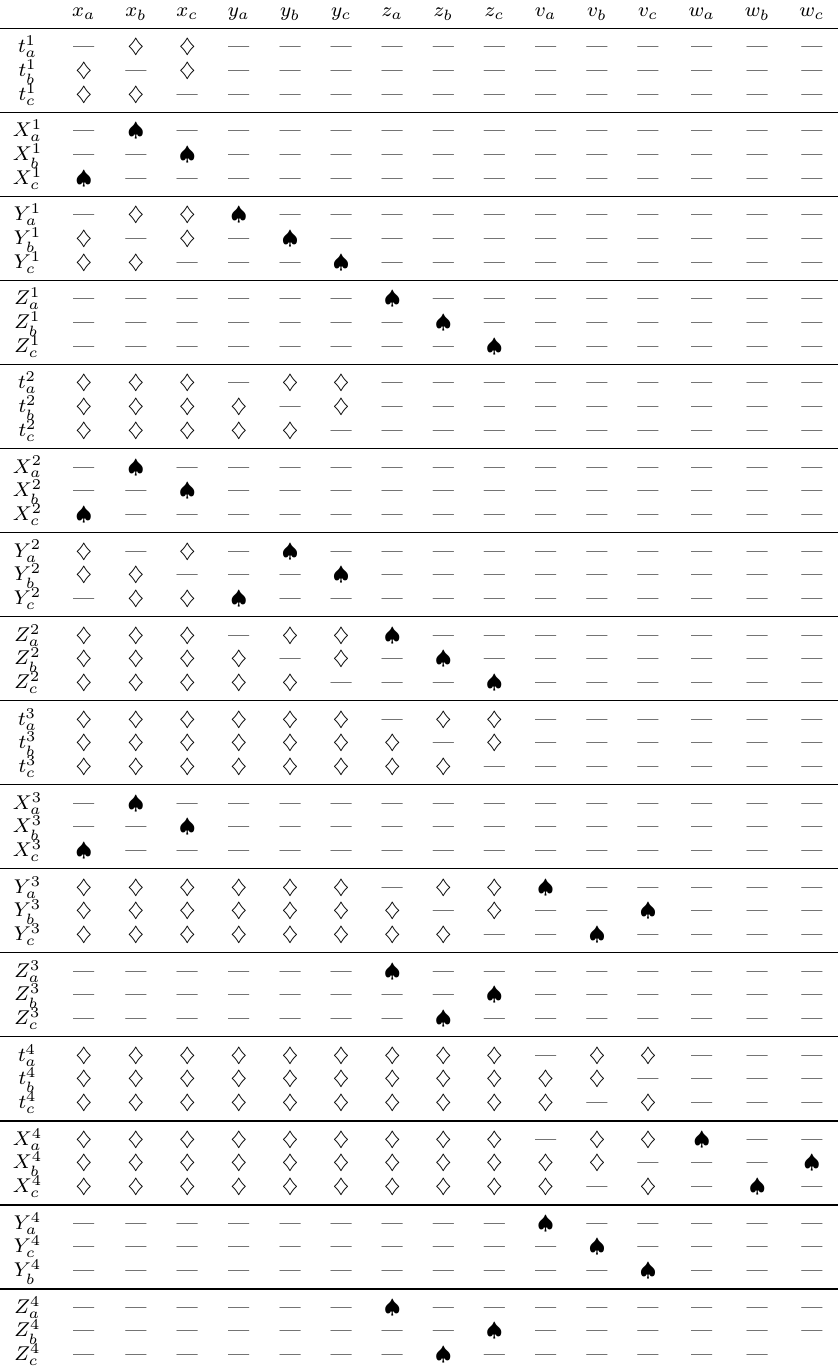
Table 3: Data propagation in the proposed S-box implementation. Row: intermediate values, column: inputs. The names of intermediate values and inputs follow Fig. 8. ♦ / ♠ is placed if the intermediate result depends on the input. ♠ is placed if the intermediate result is masked by the